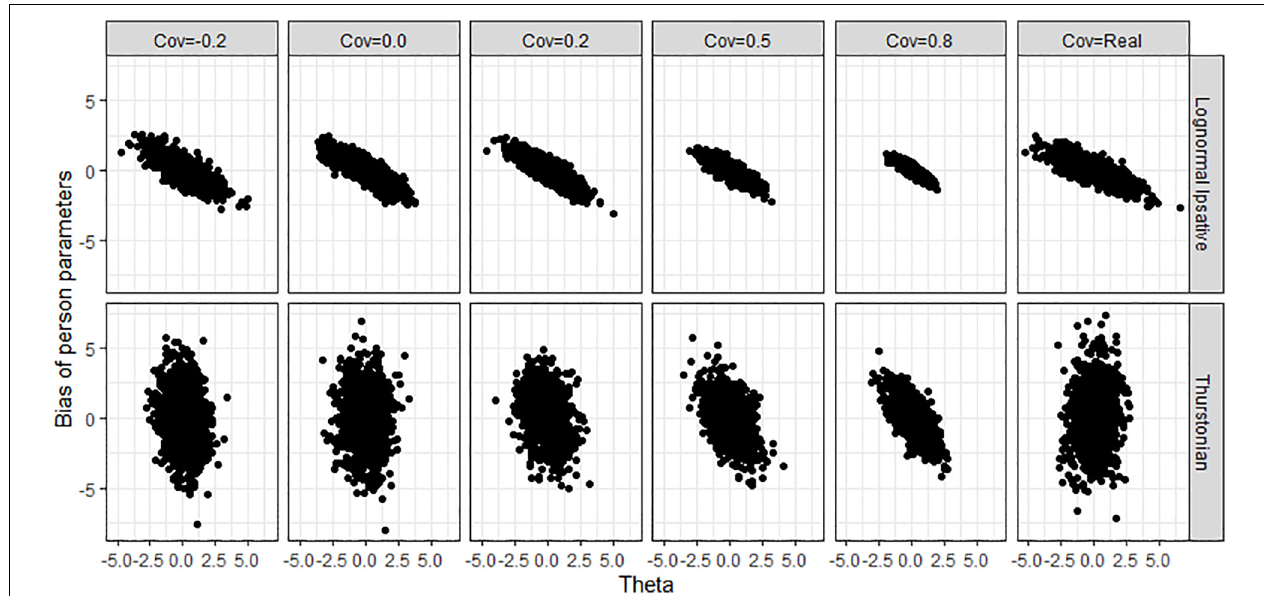
FIGURE 10 | Bias of person parameters obtained by fitting the lognormal ipsative model and the Thurstonian model to simulated data. Cov = the covariance between latent trait. Cov = Real indicates the variance-covariance matrix followed the empirical result in literature.